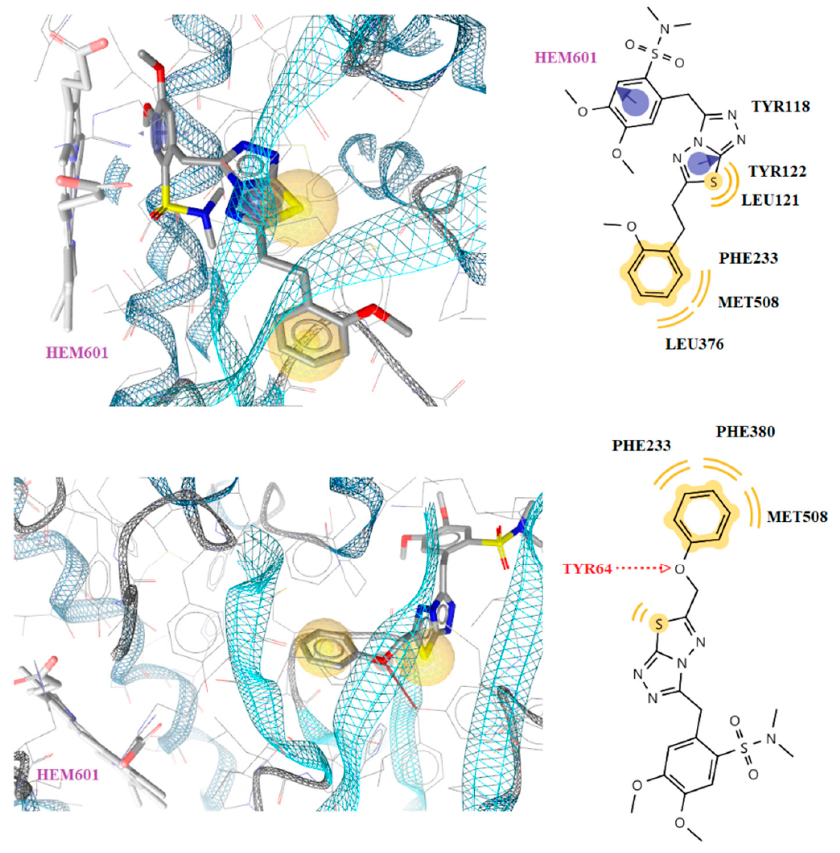
Figure 4. Docked conformation of compound 4 (up) and 6 (down) in lanosterol 14 α -demethylase of C . albicans (CYP51 ca ).